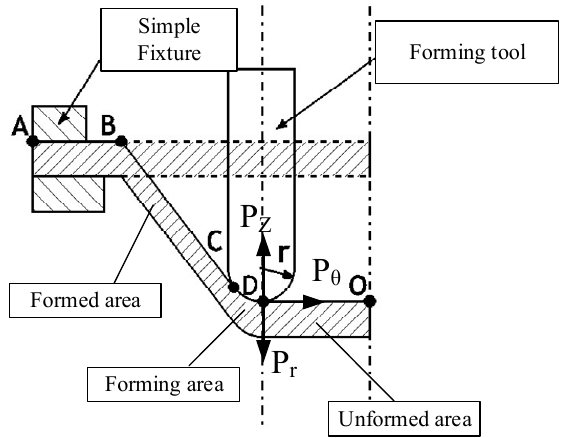
Figure 1. Progressive forming mechanism.